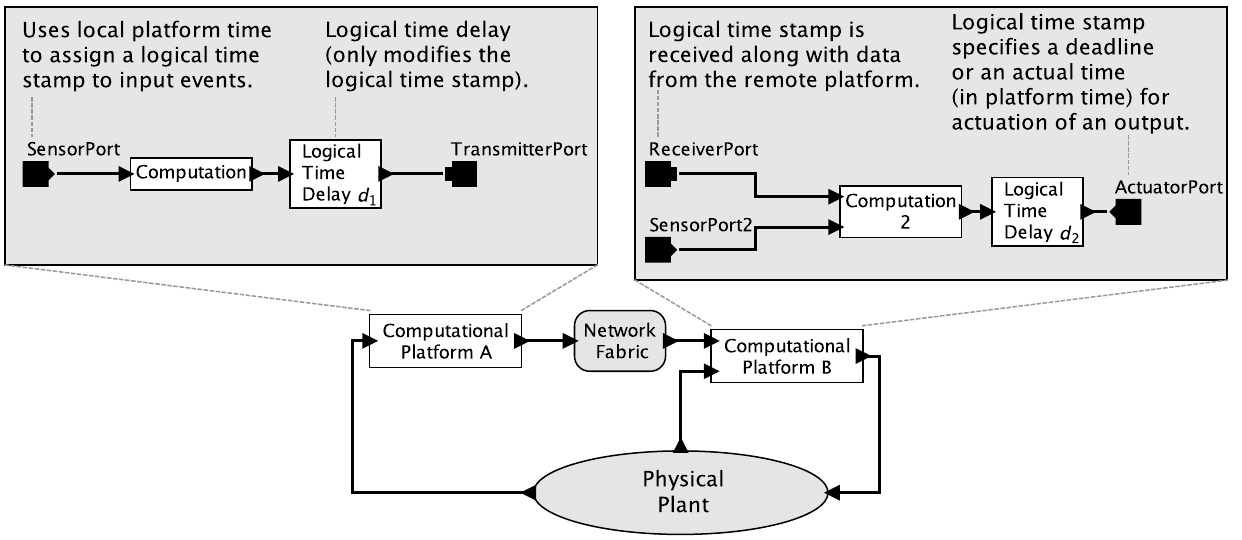
Figure 2. Structure of a simple CPS Ptides